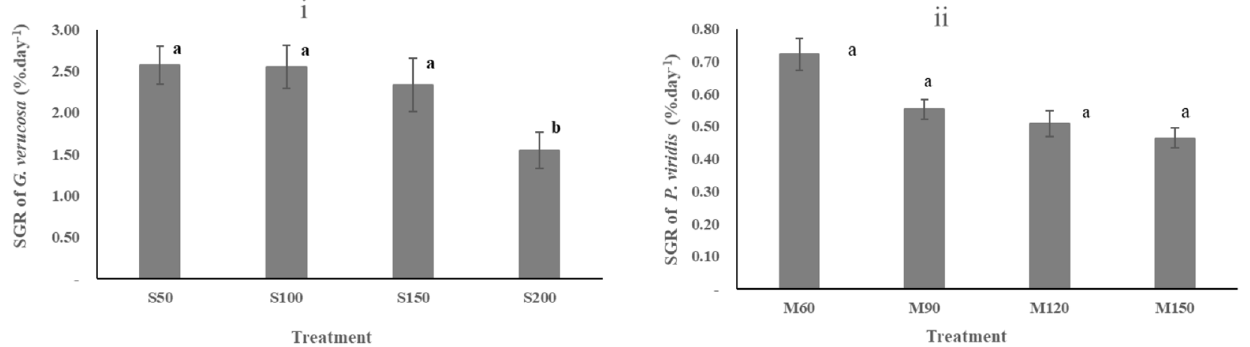
Fig. 10. Speci fi c Growth Rate (% day (cid:1) 1 ) of G. verucosa (a) and P. viridis (b) at four densities. Signi fi cant differences among the treatments are indicated by different lowercase letters.